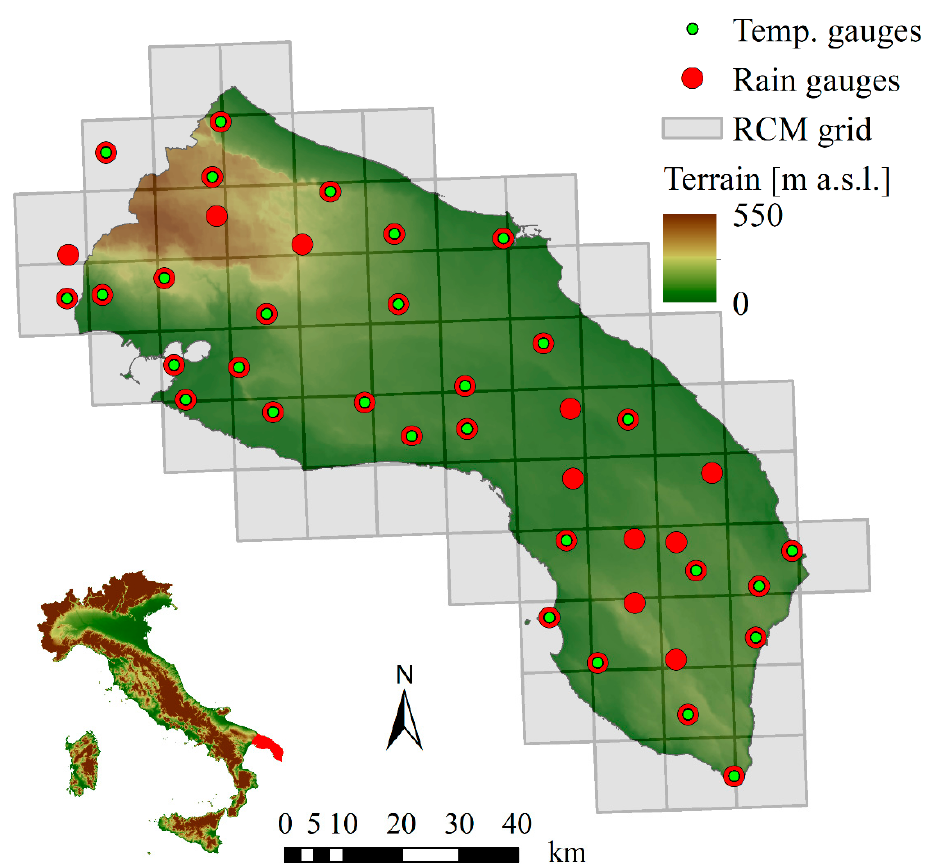
Figure 1. Study area, temperature and rain gauging station locations and portion of the EUR-11 RCM grid. Overlapping symbols identify temperature and rain gauges located in the same position.